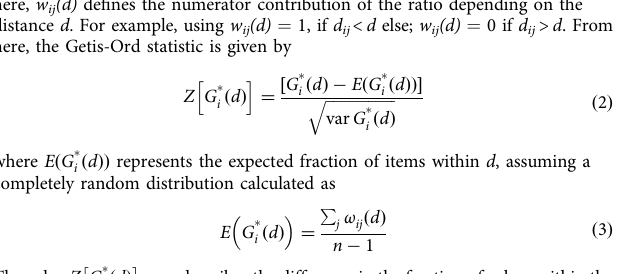
Table 1. IHC followed a routine protocol using a PT link antigen retrieval module and high pH antigen retrieval solution (both Dako Pathology/Agilent Technolo- gies, Stockport, UK). Primary and secondary antibodies were incubated for 1h at room temperature. For dual IHC staining, an ImmPRESS TM Duet Double Staining Polymer Kit (Vector laboratories, Peterborough, UK) was utilised. Negative control slides were prepared using isotype- and species-matched immunoglobulins or secondary antibody only. IF also followed a routine protocol. Antigen retrieval was carried out using a PT link antigen retrieval module and high pH antigen retrieval solution as detailed above. Primary antibodies were incubated overnight at 4 °C and secondary antibodies were incubated for 1h at room temperature. Nuclei were stained with DAPI (10.9 µM) (Sigma-Aldrich/Merck Life Science UK Limited, Gillingham, UK). Slides were mounted using Vectashield ® Vibrance TM Antifade mounting medium (catalogue H-1700; Vector laboratories, Peterborough, UK). Imaging was performed using either a Leica TCS SP8 or a Zeiss LSM780 confocal microscope. Tissue clearing and deep 3D imaging . Tissues were optically cleared using the CUBIC protocol 50,51 with minor modi fi cations as detailed below. Ovine mammary